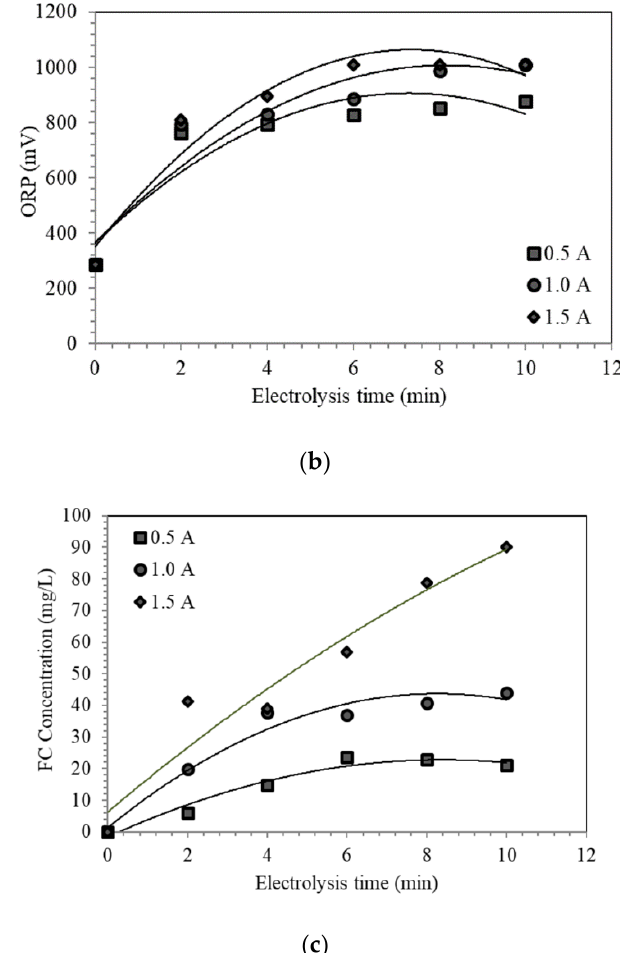
Figure 3 . Preliminary results of ten minutes of ESW conducted at 0.5 A, 1.0 A, and 1.5 A for the following physicochemical properties: ( a ) pH; ( b ) oxidation-reduction potential (ORP); and ( c ) free chlorine (FC) concentration